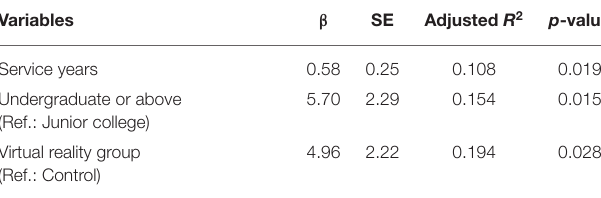
TABLE 3 | Stepwise regression of the variables affecting OSCE score ( N =